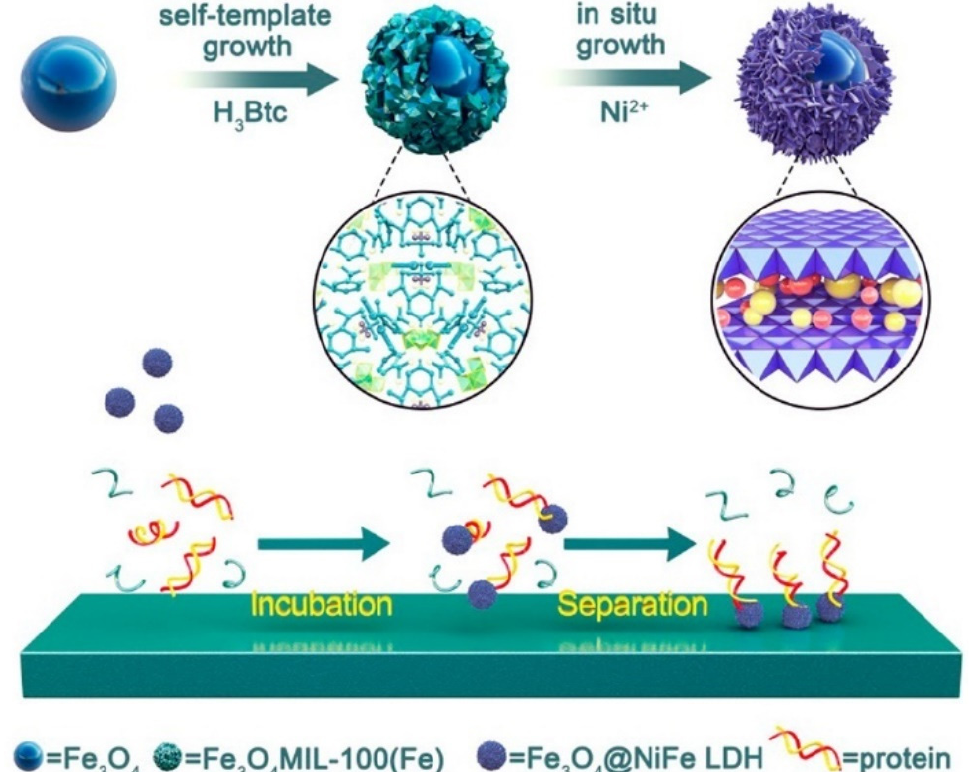
Figure 2. Proposed scheme for the synthesis of nickel/iron layered double hydroxides (LDH) through the use of an in situ cascade derivation strategy. Reprinted with permission from Wang et al. [75]